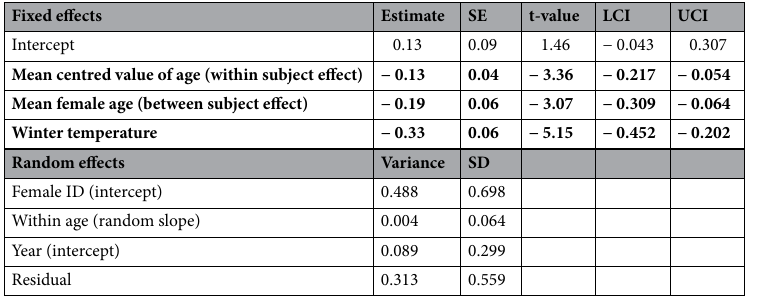
Table 2. Linear mixed effects model for the timing of breeding (ordinal date of egg laying) in relation to female breeding age and weather predictors of greylag geese in the Alm valley, Austria, (n = 619 breeding records of 155 females over 29 years). Best model (AIC c = 1411.3, ωi = 0.467; conditional R 2 = 0.703, marginal R 2 = 0.156) with random intercept, random slope (1 + age|female ID) and their correlation (r = 0.43) to evaluate plasticity. The most parsimonious model featured the mean centred value of female age (within subject effect), the mean female age (between subject effect), and winter temperature whereby older female laid eggs earlier and warmer winters were associated with earlier egg laying. Confidence intervals of parameter estimates not including zero (i.e., considered significant) are displayed in bold. Note that all quantitative input variables were scaled and centred. Null model ranked last [Akaike’s information criterion corrected for small sample size (AICc) = 1435.3, ΔAICc = 23.99]; model weight based on complete list of candidate models (n = 40).